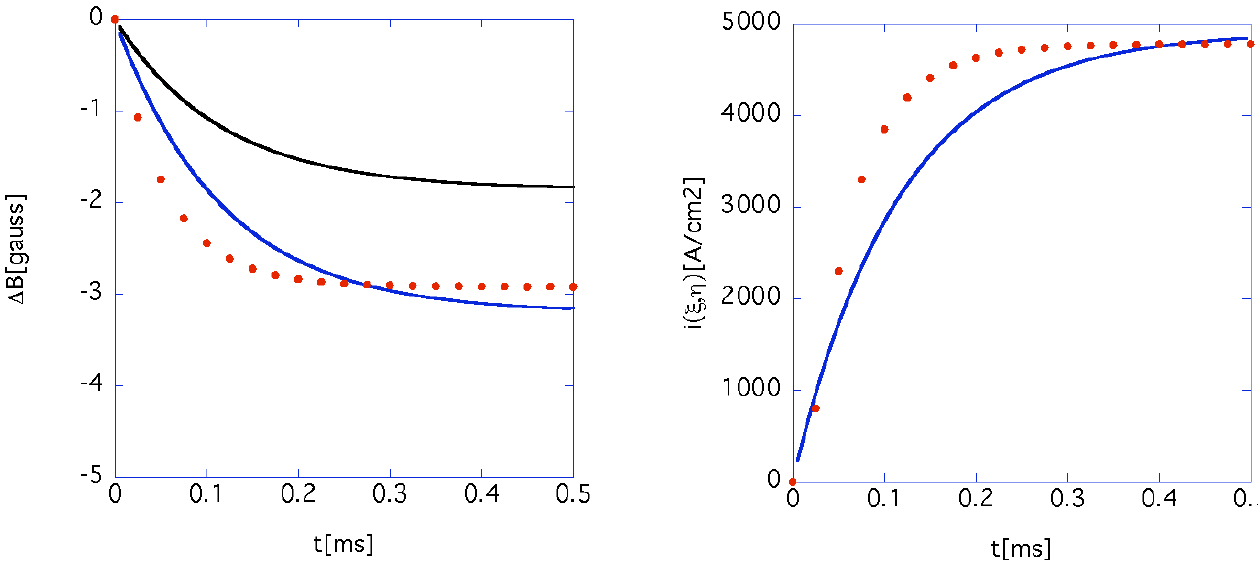
FIG. 12. (Color) The field modulation at the center of the chamber (the left figure) and the current density at the edge of stripe (the right figure). This field modulation is caused by the magnetic flux traversing isolated Cu stripes. The chamber radius a is 15.25 cm and its longitudinal length is 80.0 cm. The gap height 2 g is 32.0 cm and the gap width 2 h is 64.0 cm. The red points describe the simulated (numerical) results and the blue line does the theoretical (analytical) results where the stripe is square: 5 mm (cid:3) 5 mm . The black line in the left figure represents the theoretical (analytical) results where the stripe is cylindrical: b ¼ 2 : 5 mm